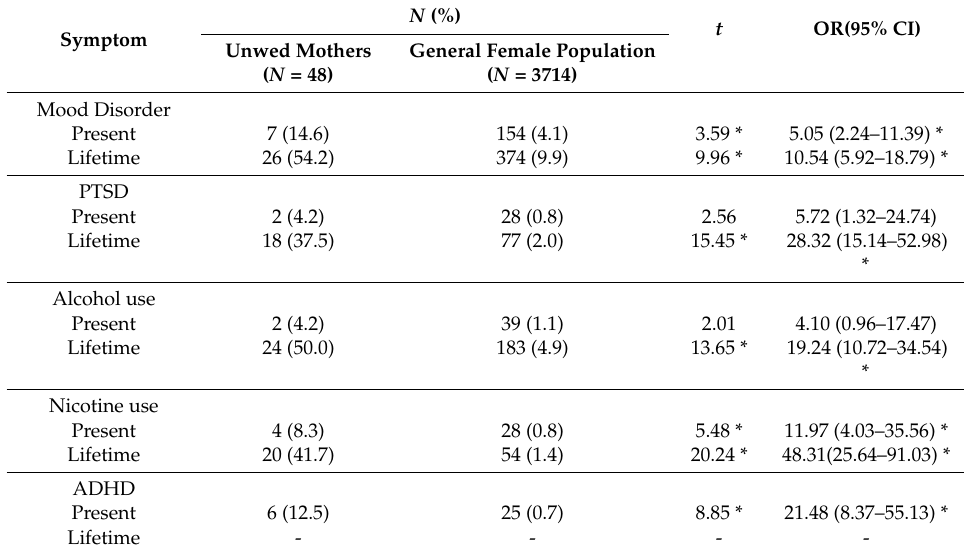
Table 2. Mental health status of unwed mothers and the general female population. N (%) t OR(95% CI) Symptom Unwed Mothers General Female Population ( N =